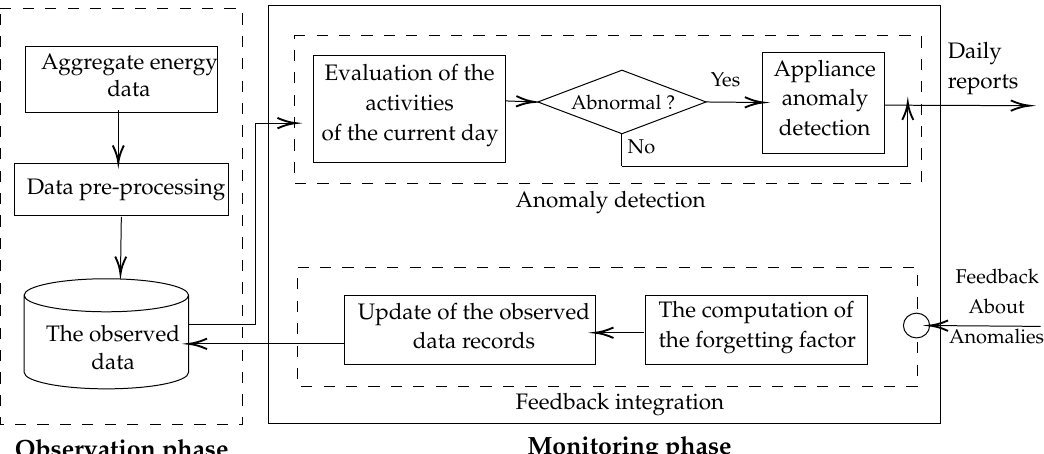
Figure 2. The monitoring and anomaly detection